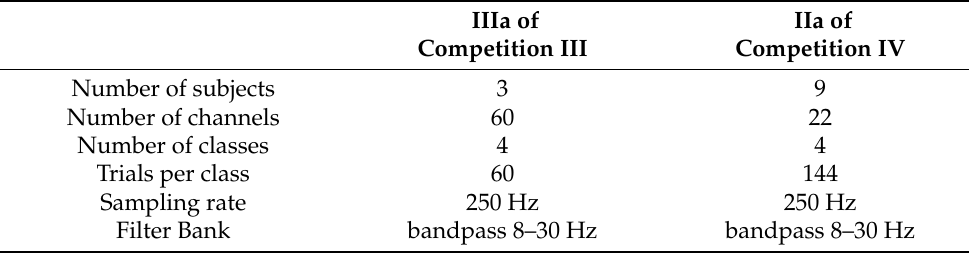
Table 3. The configuration of competition